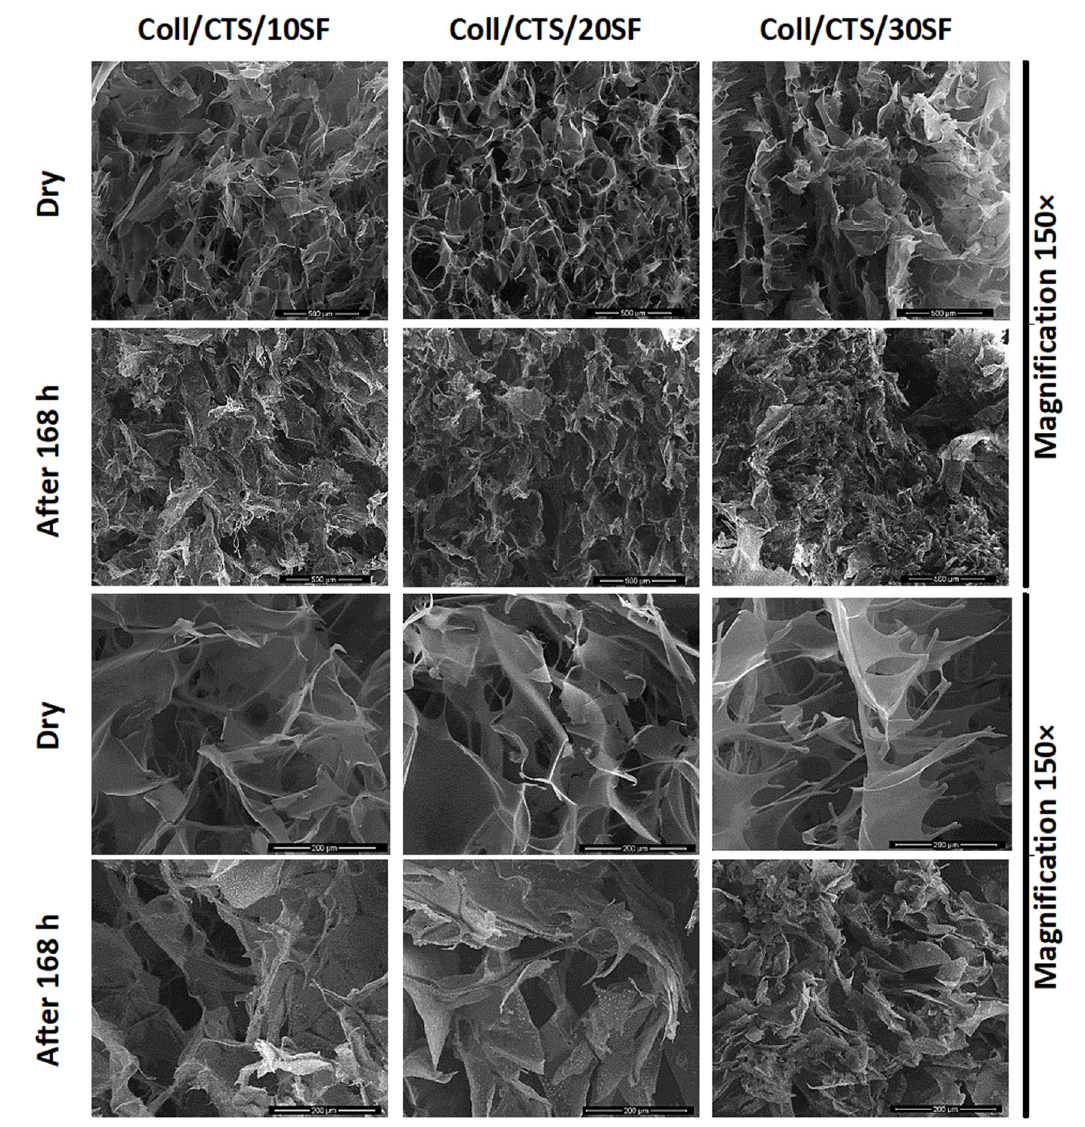
Figure 5. SEM images (magnification 500× and 150×) of Coll/CTS mixtures with 10, 20, and 30% SF (left to right columns) for dry scaffolds and after 168 h of immersion in PBS.